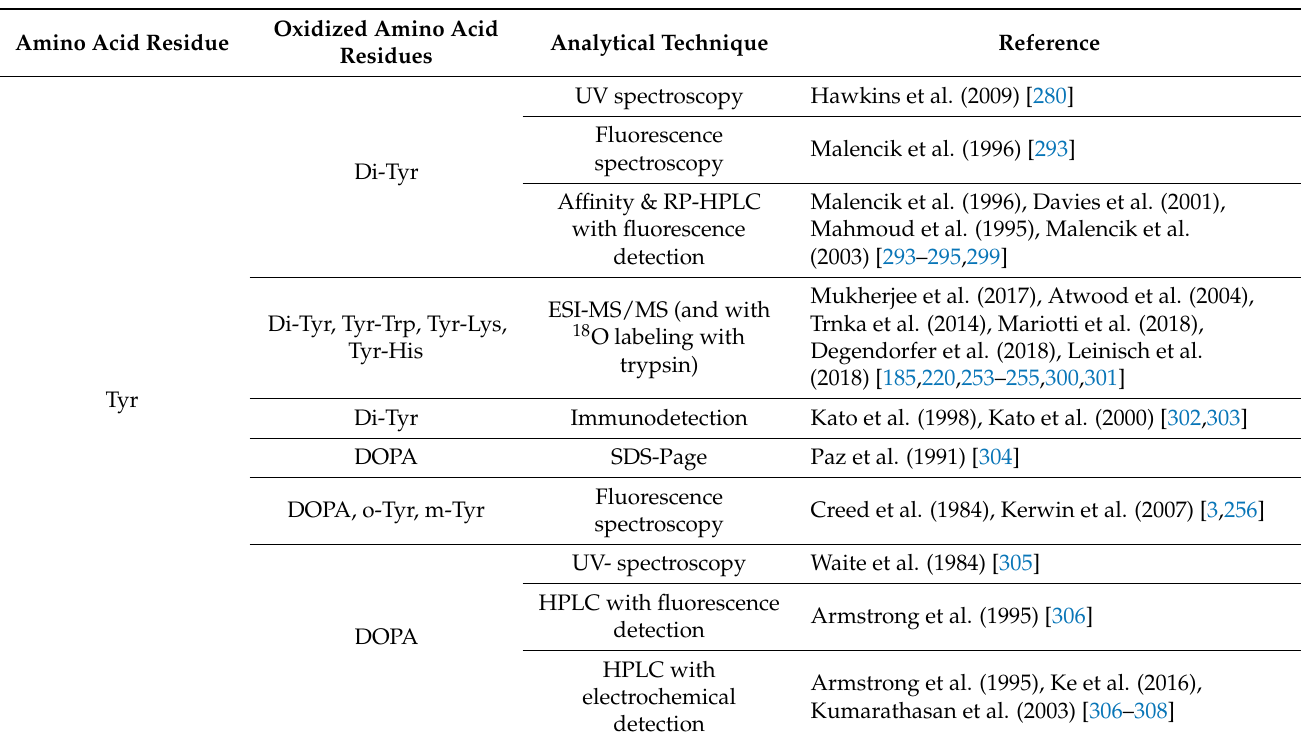
Figure 2. Chemical structures of Tyrosine and common Tyrosine photo-oxidation products such as di-Tyr (C- and O-linkage) and DOPA. Table 6. Analytical techniques/assays to detect Tyr oxidation products with the corresponding analytical techniques and relevant references.